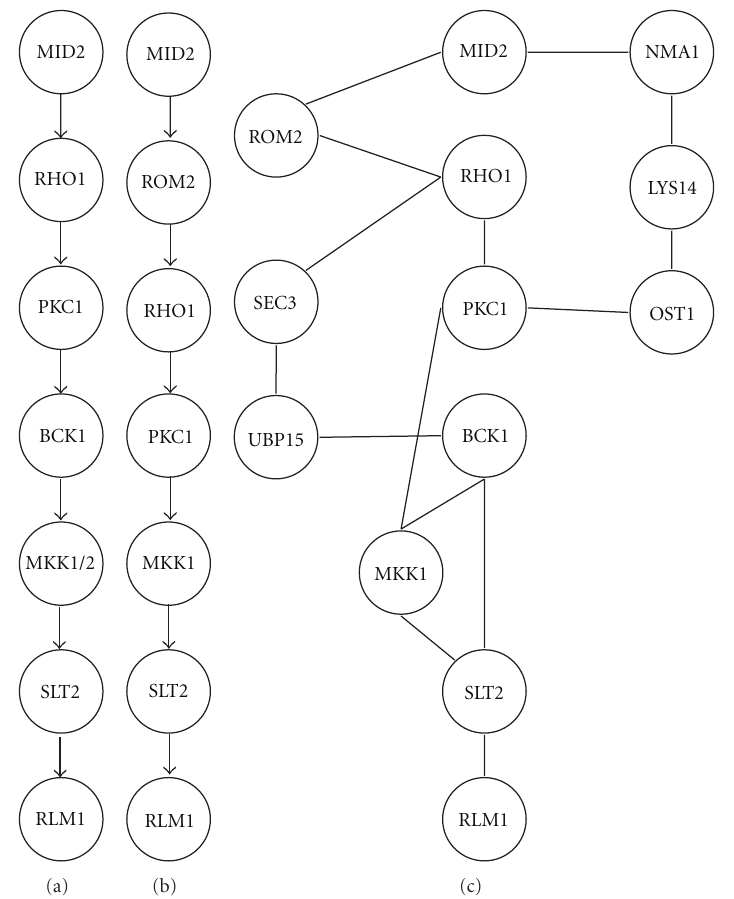
Figure 7: (a) The main chain path of cell wall integrity pathway (b) the main chain detected by Scott et al. method (c) the assembly paths detected by our